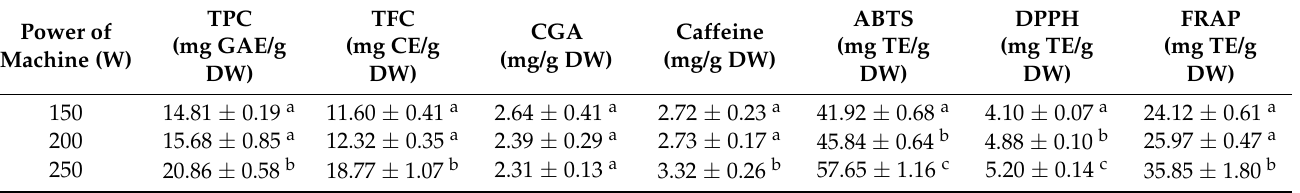
Table 3. Effect of ultrasonic power on recovery of bioactive compounds and antioxidant from coffee